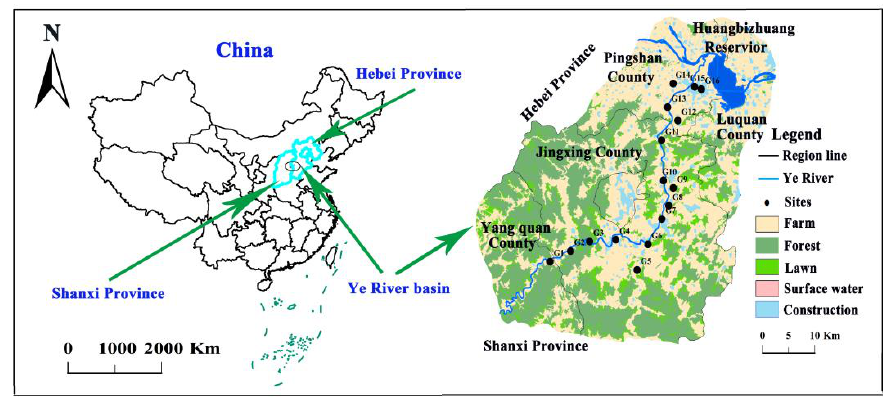
Figure 1. Groundwater sampling sites in the Ye River area.